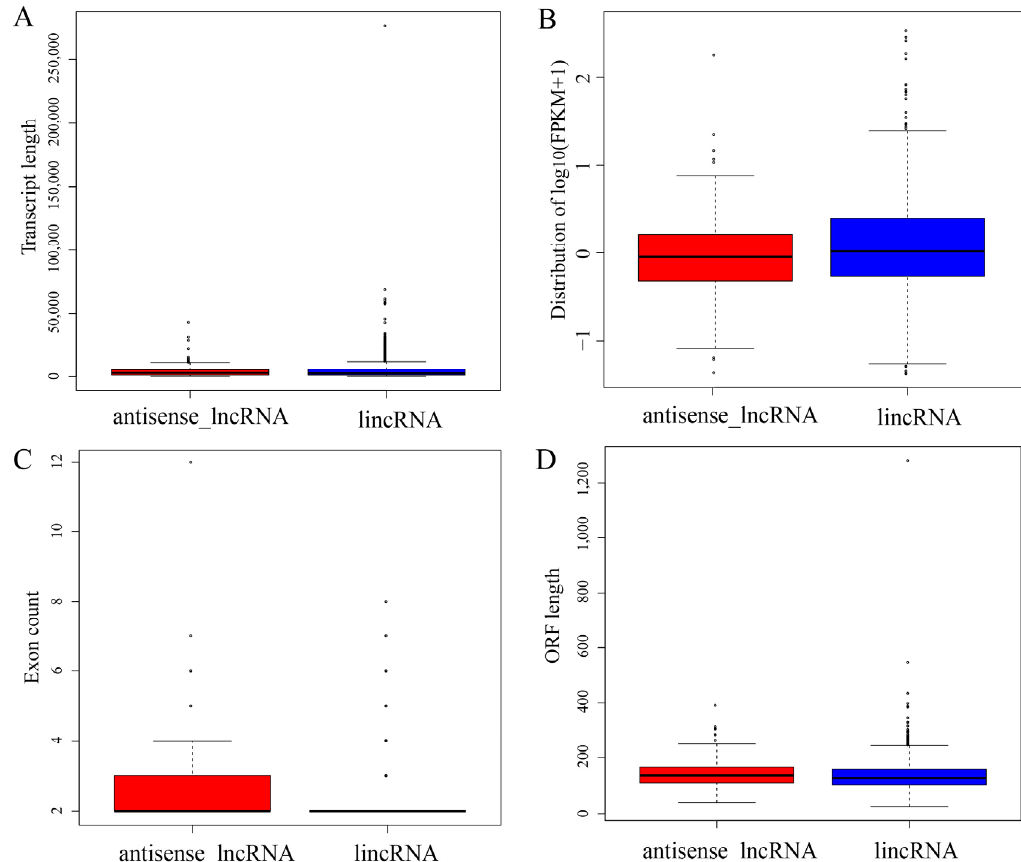
Figure 4. Genomic features of the different subtypes of lncRNAs. ( A )Transcript length, ( B ) expression level, ( C ) exon count and ( D ) ORF length of different subtypes of lncRNAs were compared using the Kolmogorov–Smirnov test. Each region of the box plot indicates the maximum, upper quartile, median, lower quartile and minimum from top to bottom.